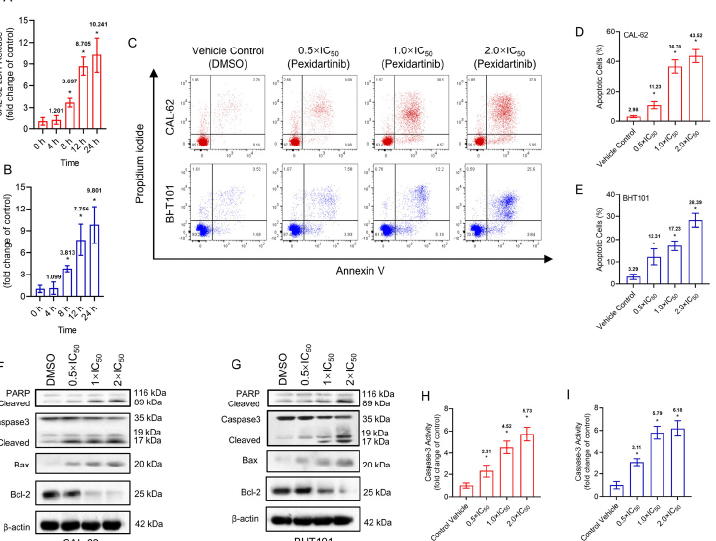
Figure 2. Pexidartinib induces cytotoxicity and apoptosis in ATC cells: ( A , B ) LDH release detected in CAL-62 and BHT101 cells after administration of pexidartinib at IC 50 concentrations for various times. ( C ) Dot blots show the apoptotic cells after pexidartinib treatment in CAL-62 and BHT101 cells respectively at 0.5 × IC 50 , 1 × IC 50 , and 2 × IC 50 concentrations. ( D , E ) The statistical analysis of pexidartinib-induced apoptosis in CAL-62 and BHT101 cells, respectively. ( F , G ) Western blot assays show the alteration of apoptosis-related proteins after pexidartinib (0.5 × IC 50 , 1 × IC 50 , and 2 × IC 50 concentrations) treatment in CAL-62 and BHT101 cells, respectively. ( H , I ) Caspase-3 activity detected in CAL-62 and BHT101 cells after pexidartinib (0.5 × IC 50 , 1 × IC 50 , and 2 × IC 50 concentrations) treatment. The original blots can be found in Figure S1. Data are presented as mean ± SD in at least three independent experiments (significance is presented as * when p <